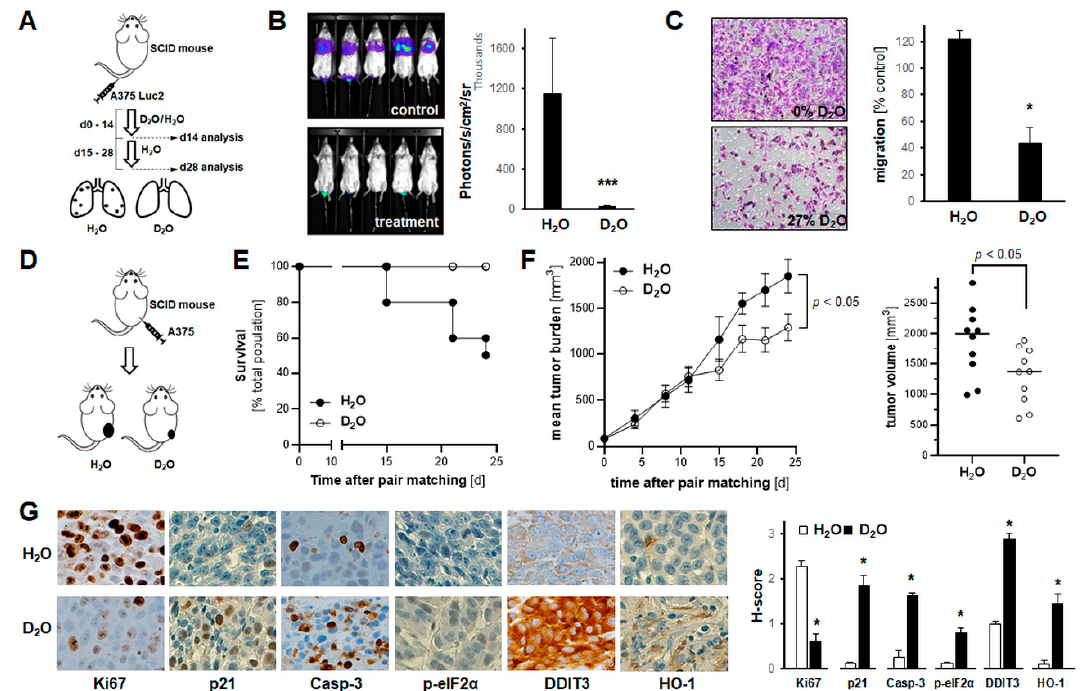
Figure 5. Systemic administration of D 2 O attenuates A375 melanoma cell invasiveness in vitro, while impairing metastasis and tumor growth in SCID mouse models of human malignant melanoma. ( A , B ) A375-Luc2 melanoma cells were tail vein injected ( n = 8 per group) followed by bioluminescent image analysis of lung metastasis (14 and 28 days later). Starting at time of cell injection until day 14, mice received H 2 O-based or D 2 O-supplemented (30% v / v in H 2 O) drinking water, followed by 14 days H 2 O in both groups. A, injection scheme; B, bioluminescent imaging (day 28) with bar graph depicting numeric image analysis of bioluminescent signal ( p *** < 0.001). (For bioluminescent imaging on day 14, see Figure S4). ( C ) Invasion through Matrigel-coated Boyden chamber (H 2 O-based versus D 2 O-supplemented (27%) medium). Bar graphs with representative images (10× magnification) after crystal violet staining of inserts ( n = 3; p * < 0.05). ( D – G ) A375 melanoma cells were injected subcutaneously ( n = 10 per group); after pair-matching, tumor growth was monitored over a 24-day period; starting at time of pair matching (day 0) until end of experiment (day 24), mice received H 2 O-based or D 2 O-supplemented (30% v / v in H 2 O) drinking water. ( D ) Experimental scheme. ( E ) Kaplan–Meier analysis of mouse survival as a function of treatment groups; numbers indicate survivors per group. ( F ) Tumor burden in treatment groups as a function of time; graph (right panel), individual tumor size at termination. ( G ) At the end of the experiment, tumors were processed for IHC (left panels; 20× magnification); bar graph: tissue H-scores per antigen (right panel; n = 3; p * < 0.05).